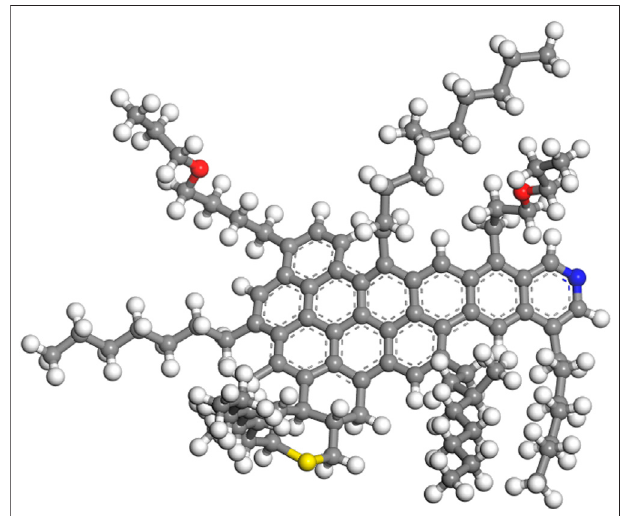
FIGURE 1 | Average molecular structure model of PEN70 asphalt